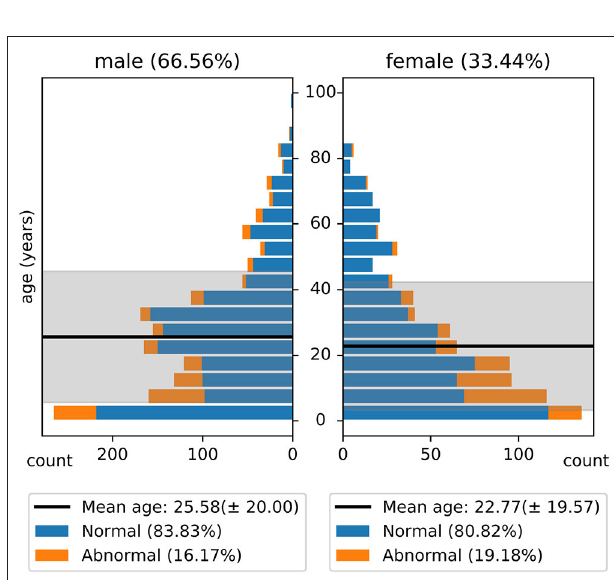
FIGURE 3 | Histogram of age distribution in the NMT dataset. The shaded regions indicate the standard deviations of the age of male and female subjects in the